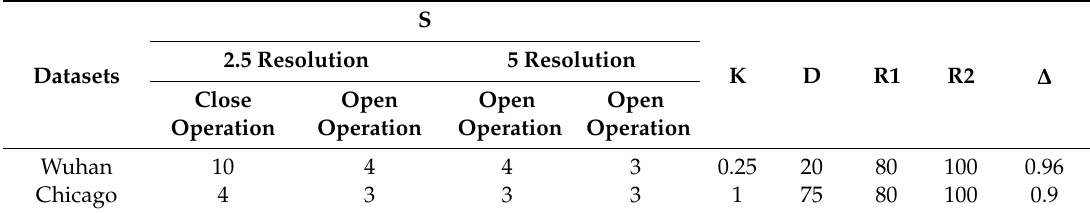
Table 2. The parameters settings for experimental